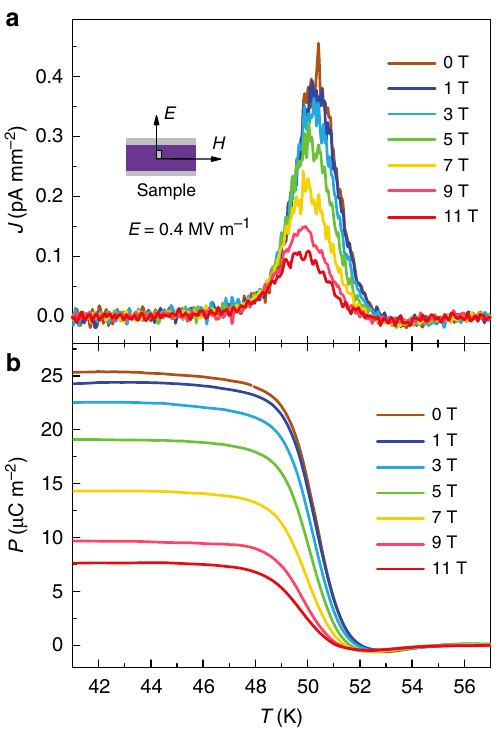
Fig. 6 Magnetic fi eld control of polarization in the binary perovskite Mn 2 O 3 . a The in fl uence of magnetic fi eld on the pyroelectric current. b The effect of magnetic fi eld on the electric polarization. The polarization is greatly reduced by applying external magnetic fi